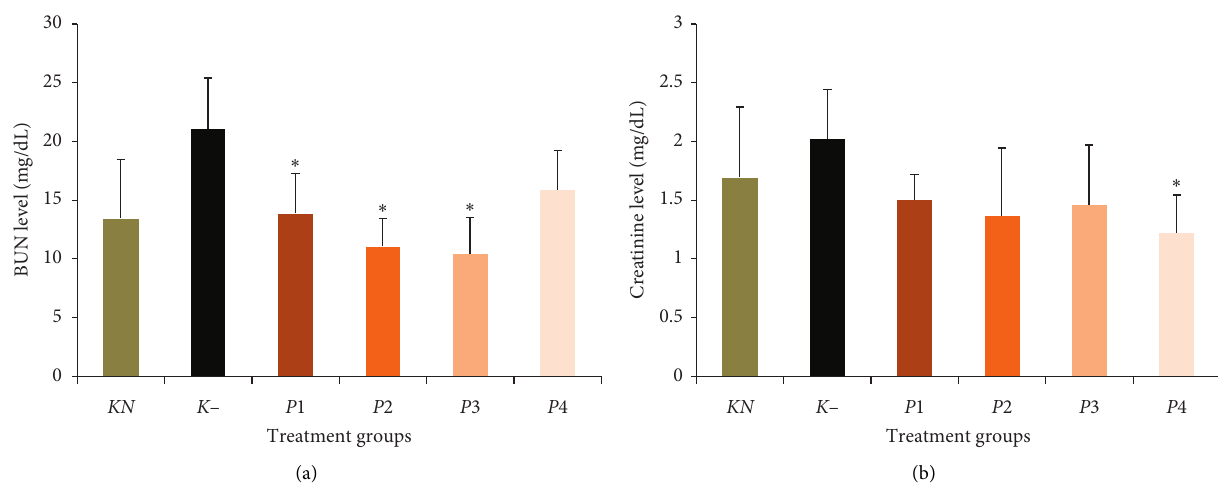
Figure 4: Effect of methanol extract of okra pods on blood urea nitrogen (BUN) and creatinine (Cre) levels. Values are as expressed as mean ± standard deviation ( n � 5). ∗ P < 0 . 05 shows significant differences in K − , confidence interval 95%. KN : normal control, K − : negative control. P 1, P 2, P 3, and P 4 were treated with 50, 100, 200, and 400mg/kg BW methanol extract of okra pods, respectively.